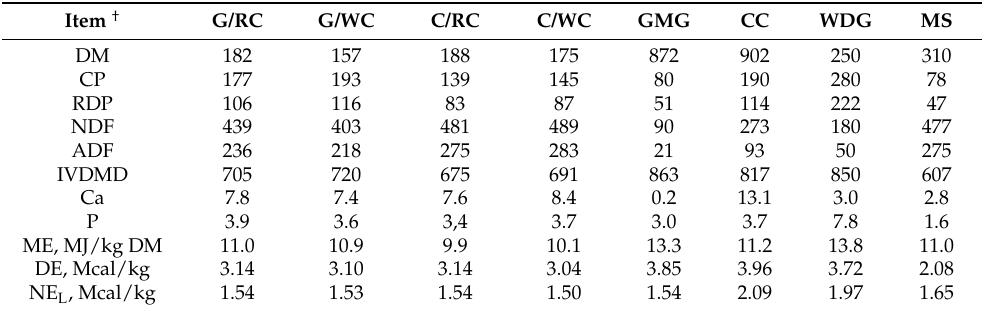
Table 3. Chemical composition (g/kg DM) of the ingredients used to shape the different feeding scenarios in dairy cows.